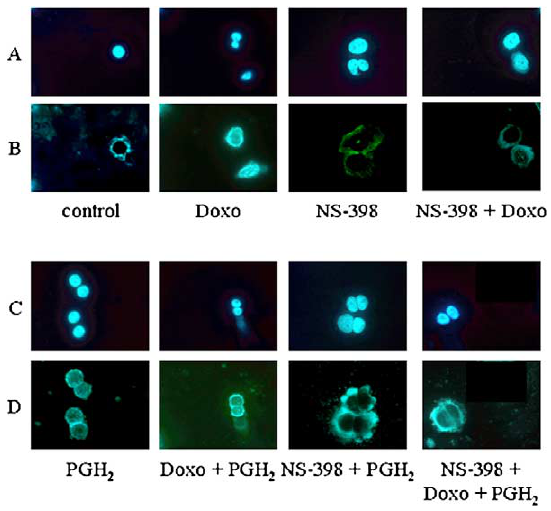
Fig. 2. Effects of PGH 2 on P-gp expression in rMCF7 cells. rMCF7 cells were treated for 2 days without (control) or with 50 nM Doxo, 10 µM NS-398, 10 µM PGH 2 alone or in combination. Cells were then incubated with the specific P-gp antibody, fixed, incubated with the secondary FITC-conjugated antibody, mounted with the antifade reagent containing DAPI, and photographed with a × 60 objective magnification. (A and C) rMCF7 cells observed with the UV filter, revealing nuclear immunofluorescence. (B and D) rMCF7 cells ob- served with the FITC filter, revealing P-gp specific membrane im- munofluorescence.